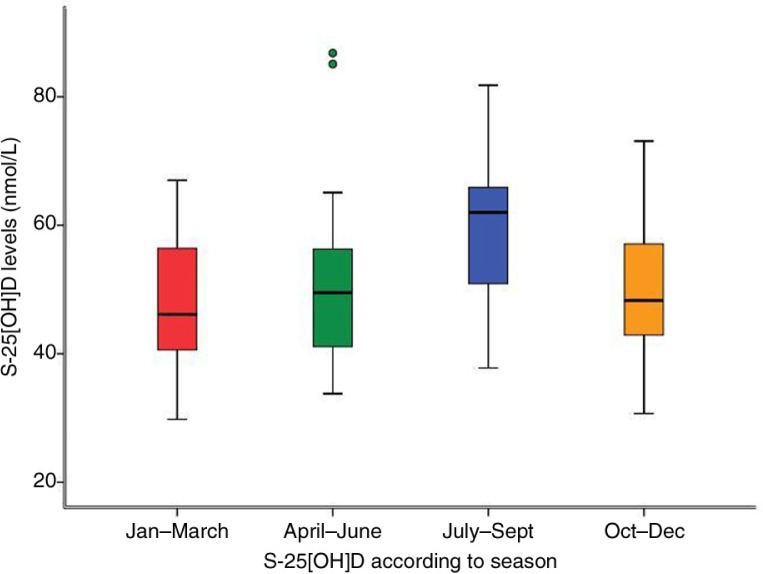
Box plot of S-25[OH]D during the four different quarters of the year. The values represent the median (horizontal lines), interquartile range (box), and range of values (whiskers). The children tested during the third quarter (July–September) had the highest measured levels of S-25[OH]D (Md=62 nmol/L), the other groups (January–March, April–June, and October–December) had median levels of 46, 50, and 48 nmol/L, respectively.